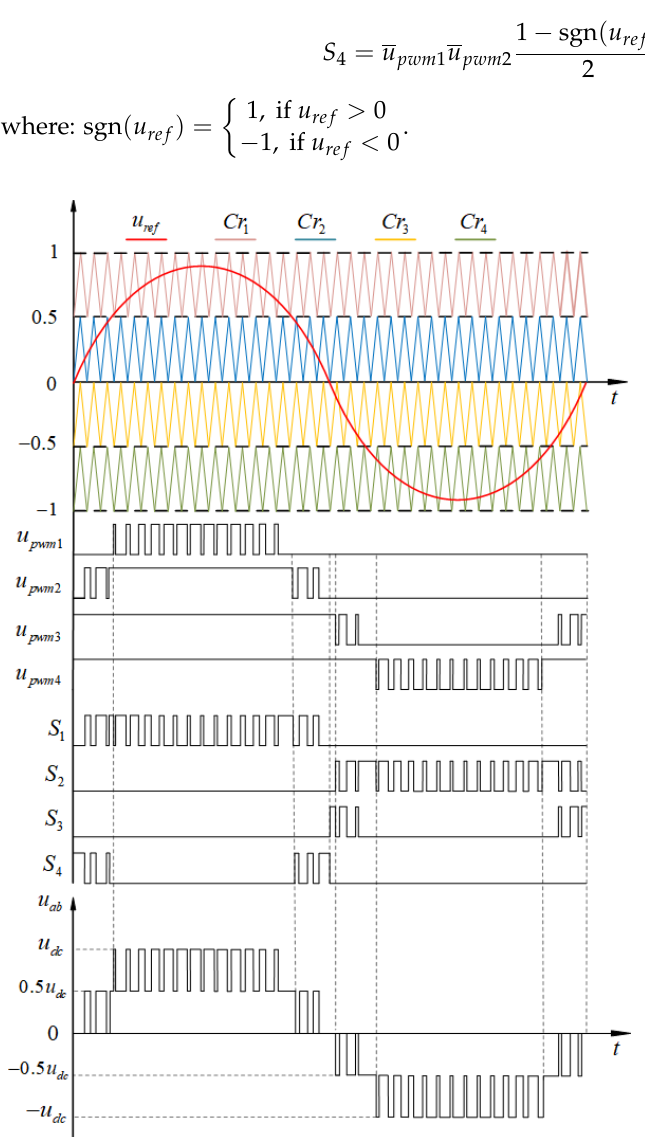
Figure 8. The pulse width modulation principle of the proposed PFC. In the pulse signal waveforms of the switches S 1 , S 2 , S 3 , and S 4 , the high-level and the low-level represent the “ON” and “OFF” signals of the switches, respectively. The proposed PFC topologies can operate according to the modes in Table 1 through the mutual cooperation between the pulse signals of each switch, so that the bridge-arm voltage u ab can be